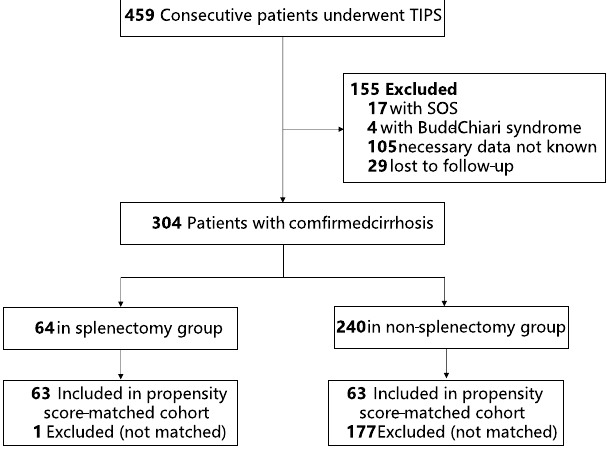
Figure 1. Flowchart of the patient selection protocol. SOS, hepatic sinus obstruction syndrome.